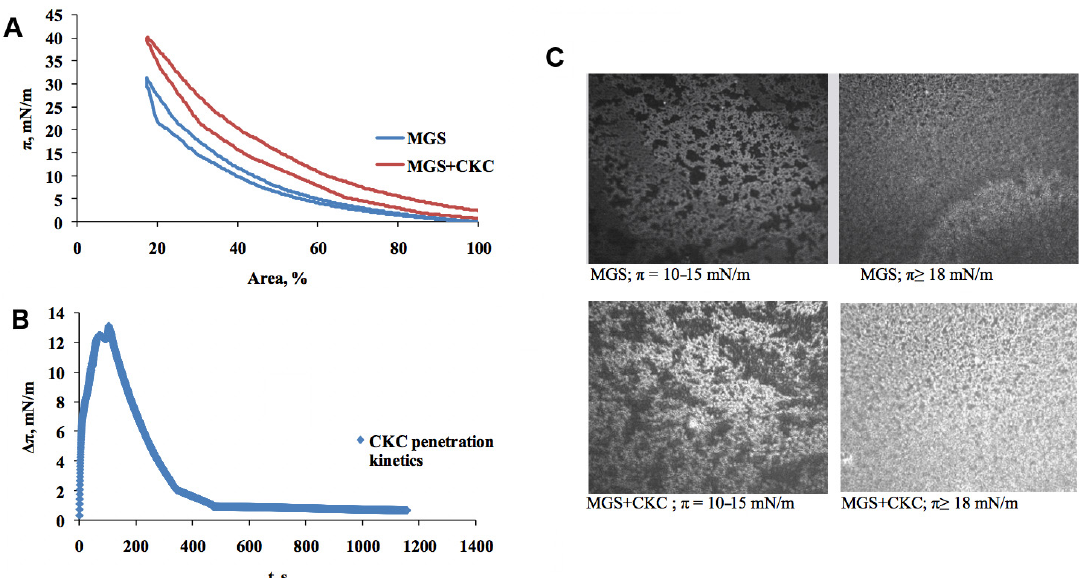
Figure 1. Meibomian gland secretion influenced by cetalkonium chloride (CKC). Lateral pressure–surface area isotherms of meibomian gland secretion (MGS) and MGS in the presence of 3.6 × 10 − 7 M CKC ( A ), a single compression–decompression experiment data are presented; penetration kinetics of 3.6 × 10 − 7 M CKC to MGS film pre-equilibrated at 18 mN/m ( B ); Brewster Angle Microscopy images (500 × 500 μ m field of view) of MGS and MGS in the presence of 3.6 × 10 − 7 M CKC ( C ).